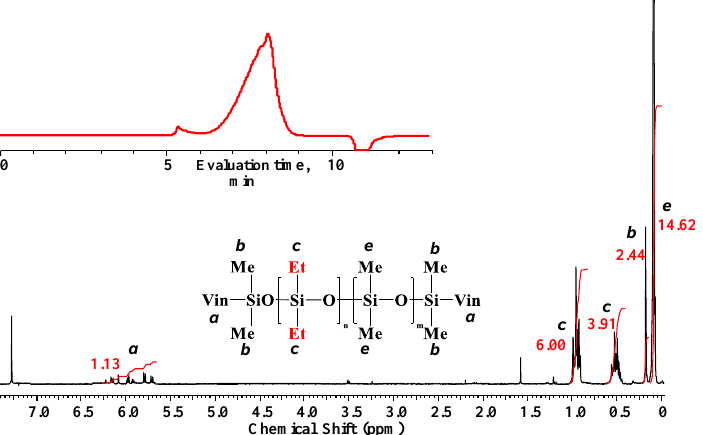
Figure 5. 1 H NMR spectrum and GPC curve of blocked linear poly(diethyl)(dimethyl)siloxane (№ 10, Table 2).